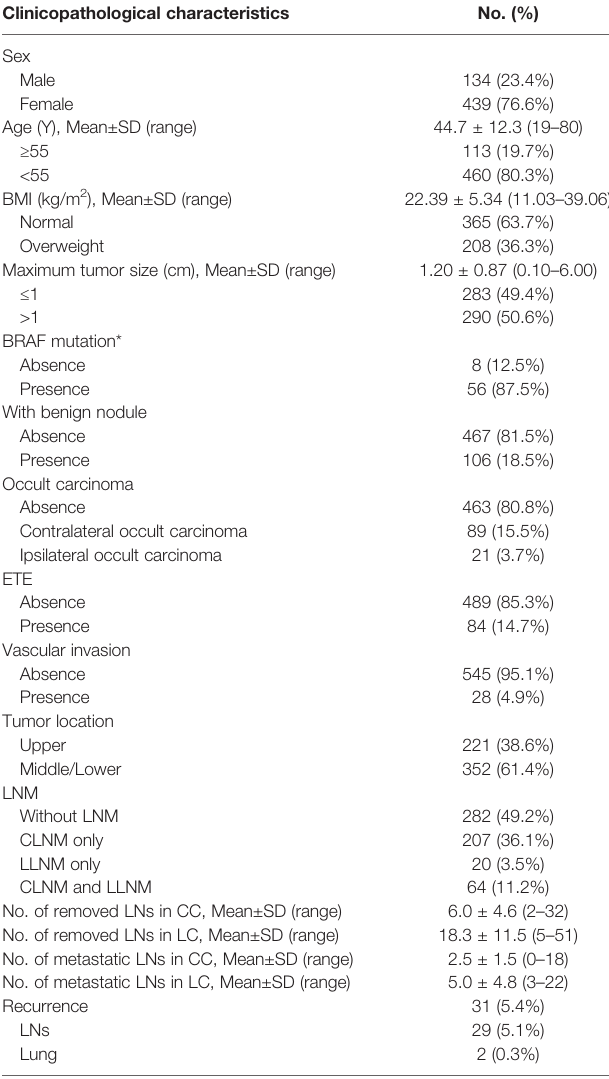
TABLE 1 | Clinicopathological characteristics of 573 PTC